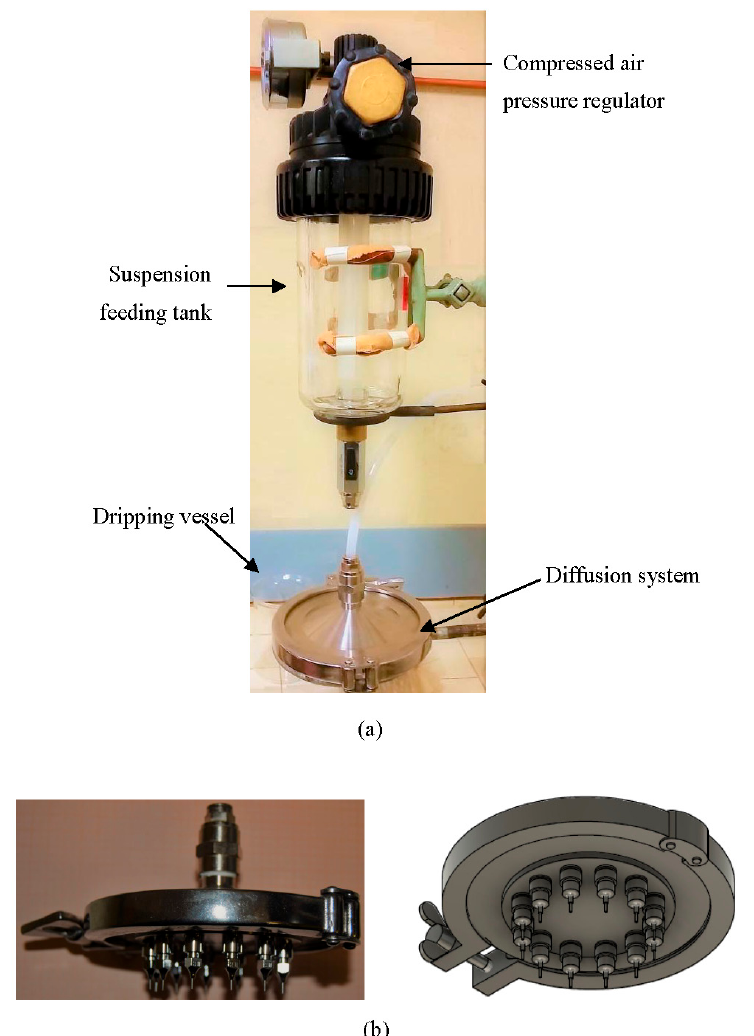
Figure 4. Overview of the experimental device ( a ) with details (photographs and schematic overview) of the dripping sub-systems with the view of the nozzles ( b ).